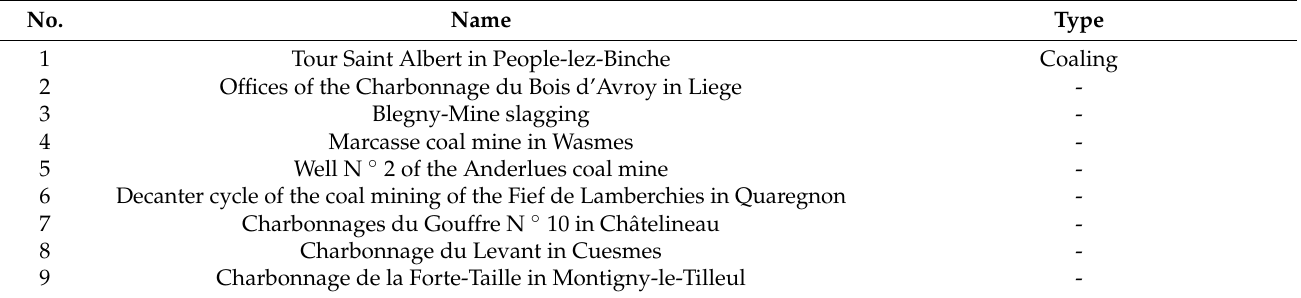
Table A2. Names and types of Industrial heritages’ in